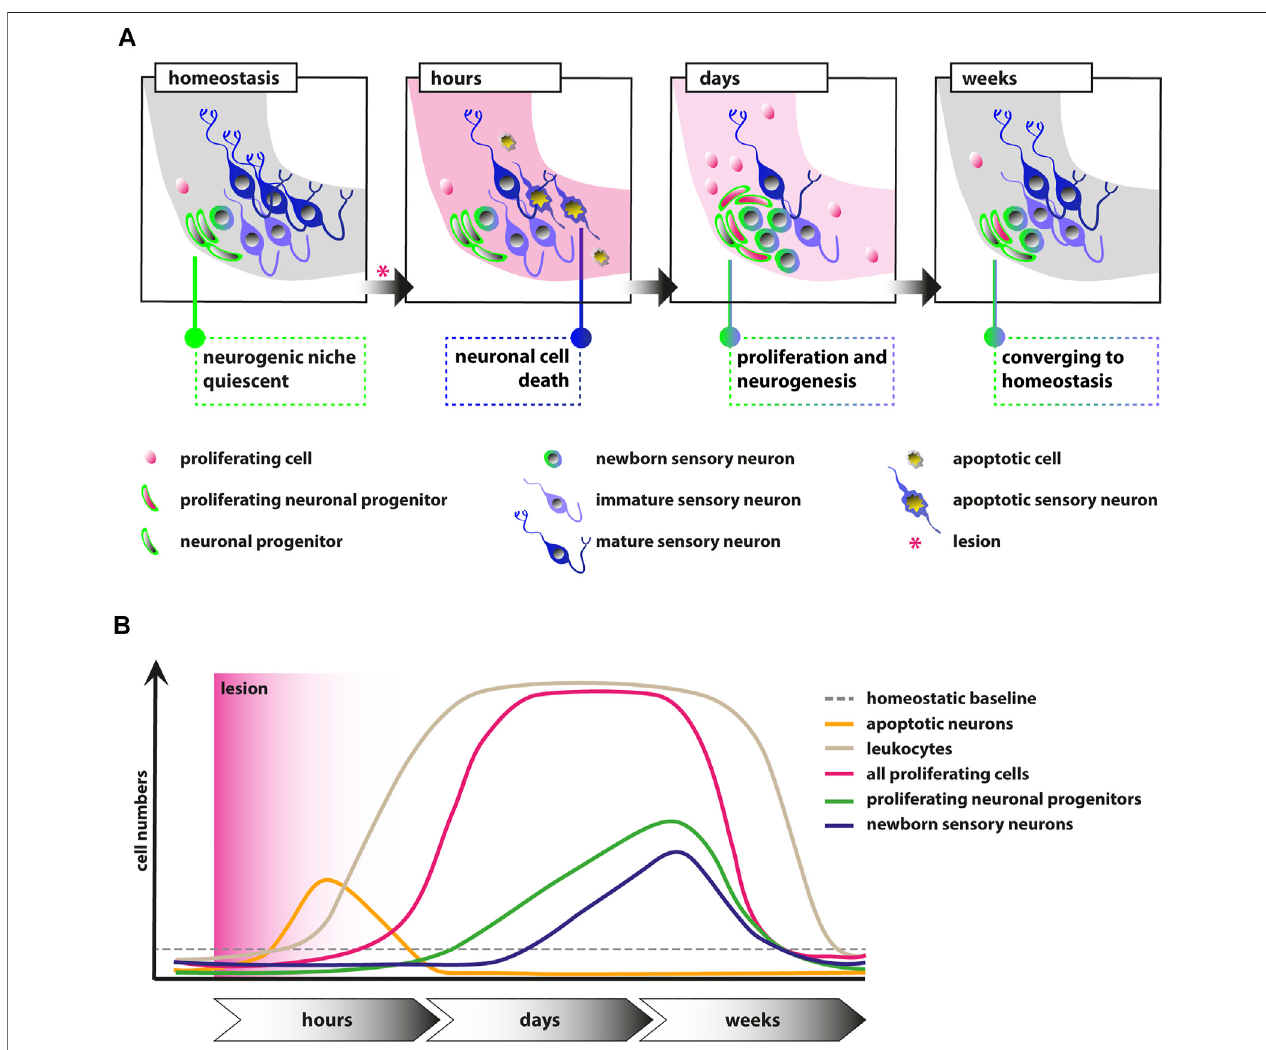
FIGURE 7 | Schematic illustrations of the events in the adult zebra fi sh SAG upon lesion. (A) Scheme depicting the cellular events within the neurogenic niche. During homeostasis, the neurogenic niche of the adult zebra fi sh SAG is quiescent in regard to proliferation and shows only very rare neurogenesis. Upon lesion, mature sensory neurons as well as other marker-negative cells undergo apoptosis within several hours. Within days, reactive proliferation of marker-negative and neuronal progenitor cells is observed accompanied by reactive neurogenesis from the neuronal progenitor pool. Reactive proliferation and reactive neurogenesis continue over the next weeks until previous homeostatic levels are reached. (B) Scheme of the temporal order of events. During homeostasis, only basal levels of proliferating marker-negative cells, proliferating neuronal progenitors, and leukocytes are present in the neurogenic niche of the SAG. In addition, only basal levels of newborn neurons derived from the neuronal progenitors and no apoptotic cells are found. Upon lesion, a strong increase in the number of apoptotic cells and, in particular, apoptoticsensoryneuronsisobserved,whichisalsoresolvedrapidly.Alsowithinhours,amassiveaccumulationofleukocytesoccurs,whichpersistsforseveralweeks. Within days,thenumberofproliferatingcellsincreasessigni fi cantlywithintheneurogenicnicheoftheSAGandremains highforacoupleofweeksuntilitreturnstolower levels. Following the general gain in proliferation, the number of proliferating neuronal progenitors is also signi fi cantly increased for approximately 2 – 3 weeks until it returns to baseline levels. Onset of proliferation of neuronal progenitors is accompanied by increased production of newborn neurons, which remains high for approximately 2 – 3 weeks until it returns to homeostatic levels.